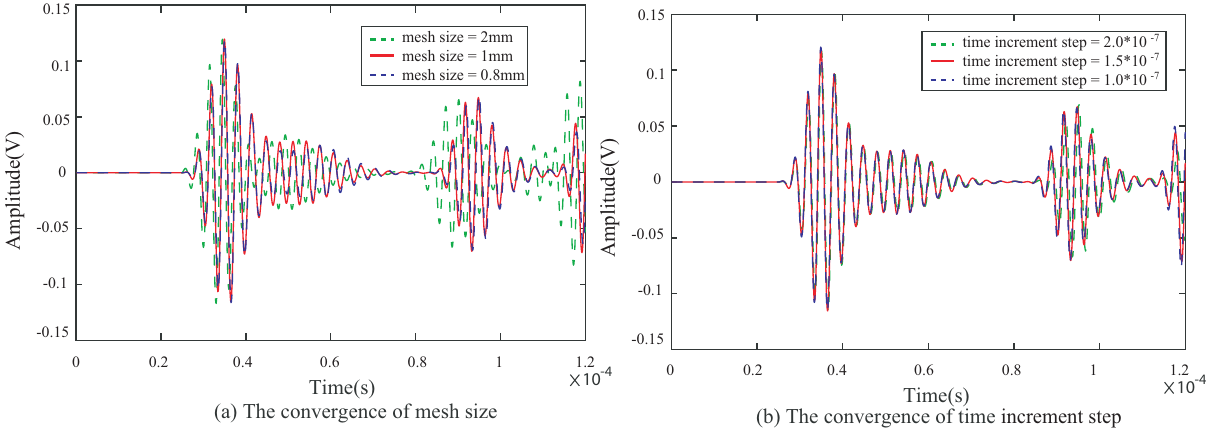
Figure 8. Results of convergence analysis: ( a ) mesh size and ( b ) time increment